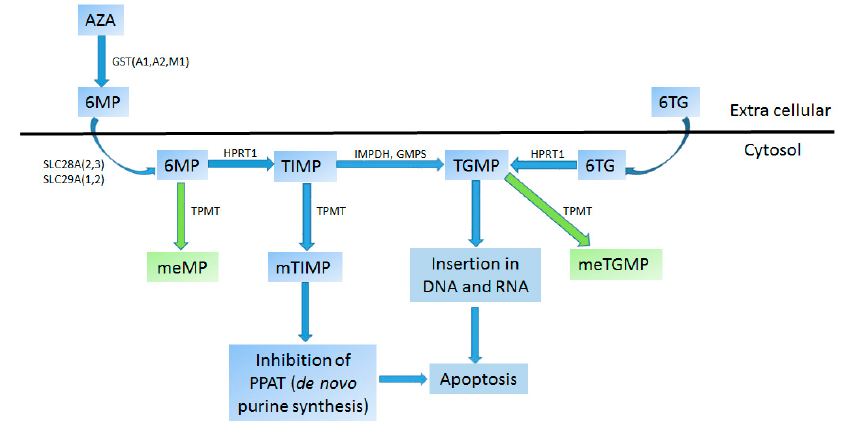
Figure 2. Metabolism of thiopurine S -methyltransferases (TPMT). Metabolite: Azathioprine (AZA), Figure 2. Methylmercaptopurine (meMP), Methyl-thioguanosine monophosphate (meTGMP), Methyl- thioinosine monophosphate (mTIMP), Thioguanosine monophosphate (TGMP), Thioinosine